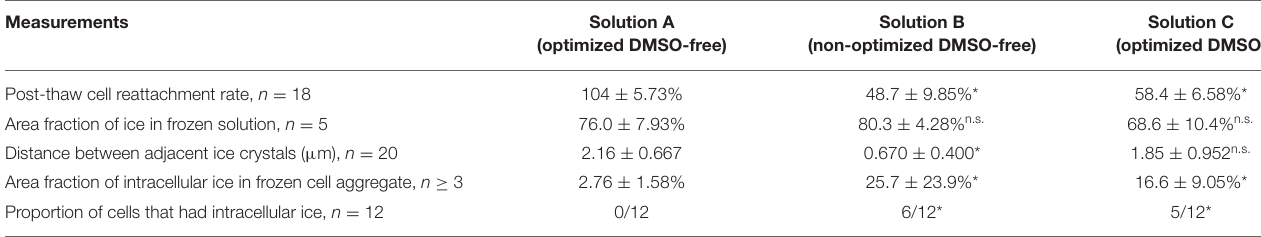
TABLE 3 | Comparison of freezing responses in Solutions A, B, and C under optimal cooling rate of –1 ◦ C/min and ice nucleation temperature of –4 ◦ C a .